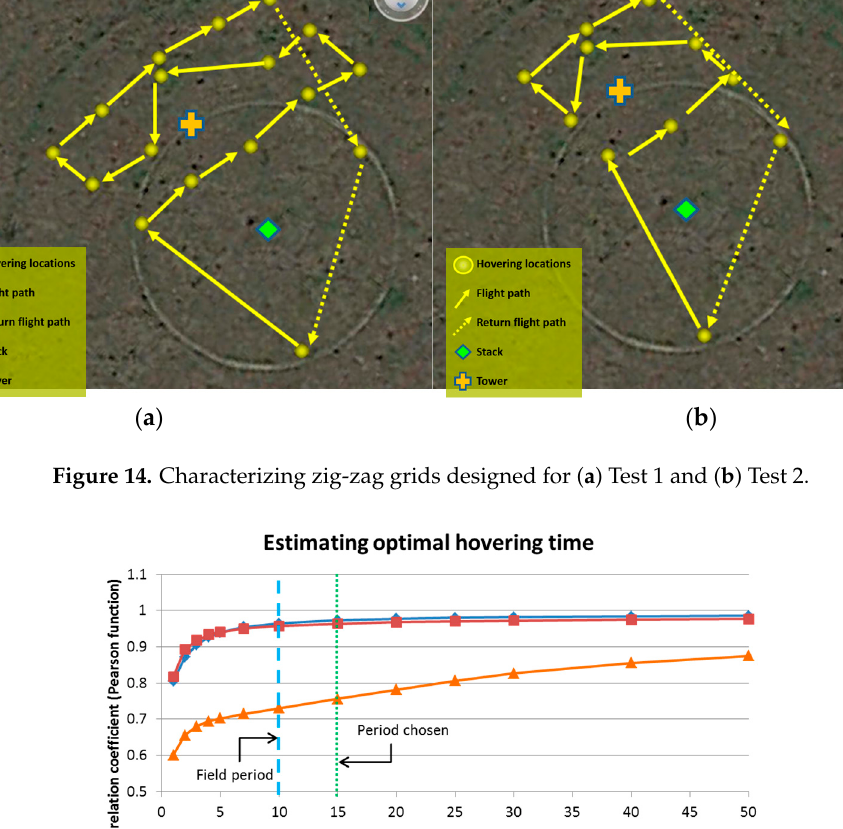
Table 3. Bins considered to calculate PM 10 concentrations and their boundaries according to particle diametre.